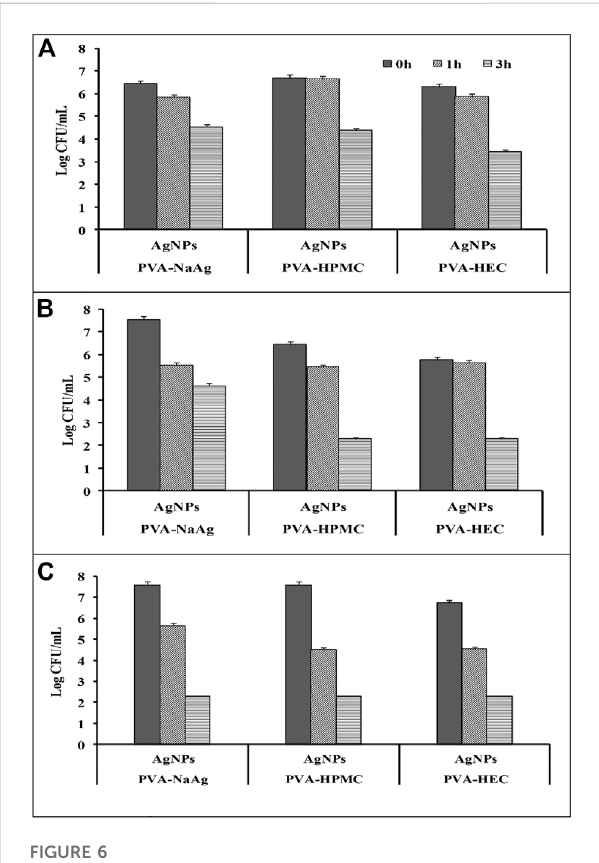
FIGURE 6 Antibacterialef fi cacyofBMNPsincorporatedfacialpeel-offPVA- NaAlg, PVA-HPMC, and PVA-HEC mask gel against pathogenic bacteria Staphylococcus aureus ATCC 25923 (A) , Staphylococcus epidermidis ATCC1228 (B) , and Pseudomonas aeruginosa ATCC 27853 (C) . Reproduced with permission (Singh et al., 2022b). Copyright 2022, Springe